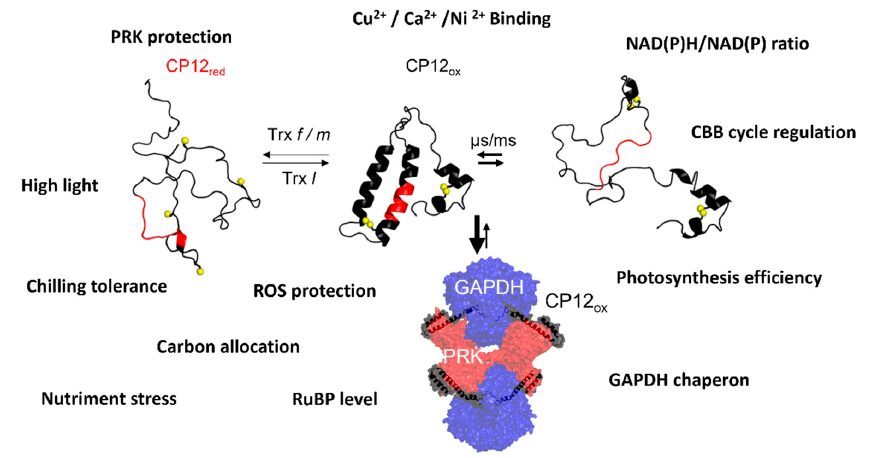
Figure 6. Atlas of CP12 functions. The core sequence of CP12, AWD_VEEL, is in red, and sulfur atoms are indicated in yellow. Reduced CP12 is fully disordered, and oxidized CP12 is partially ordered. Under oxidized state, CP12 forms a supramolecular complex with GAPDH and PRK. A non-exhaustive list of CP12 functions is indicated in the scheme.